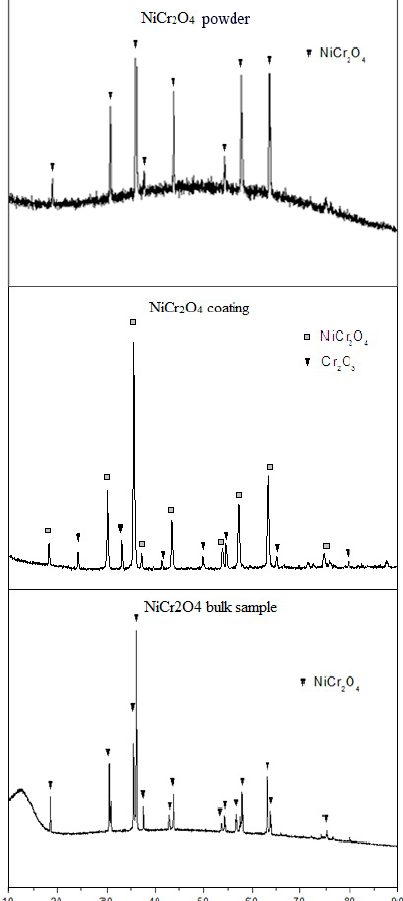
Figure 1. XRD patterns of NiCr 2 O 4 original powder, coating, and bulk sample.